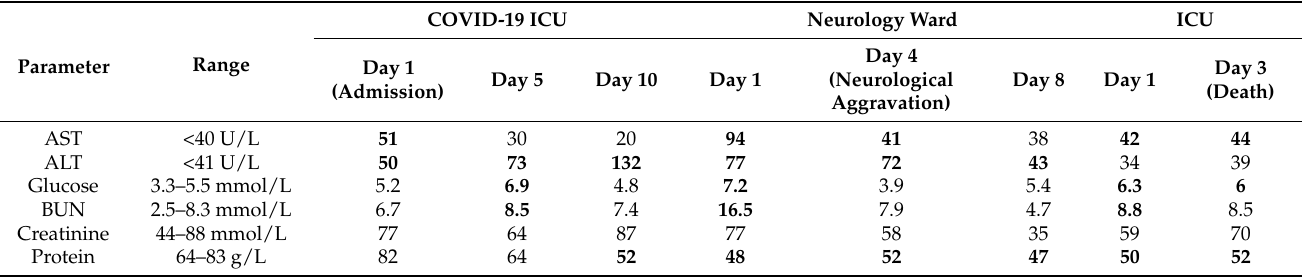
Table 3. Evolution of biochemical